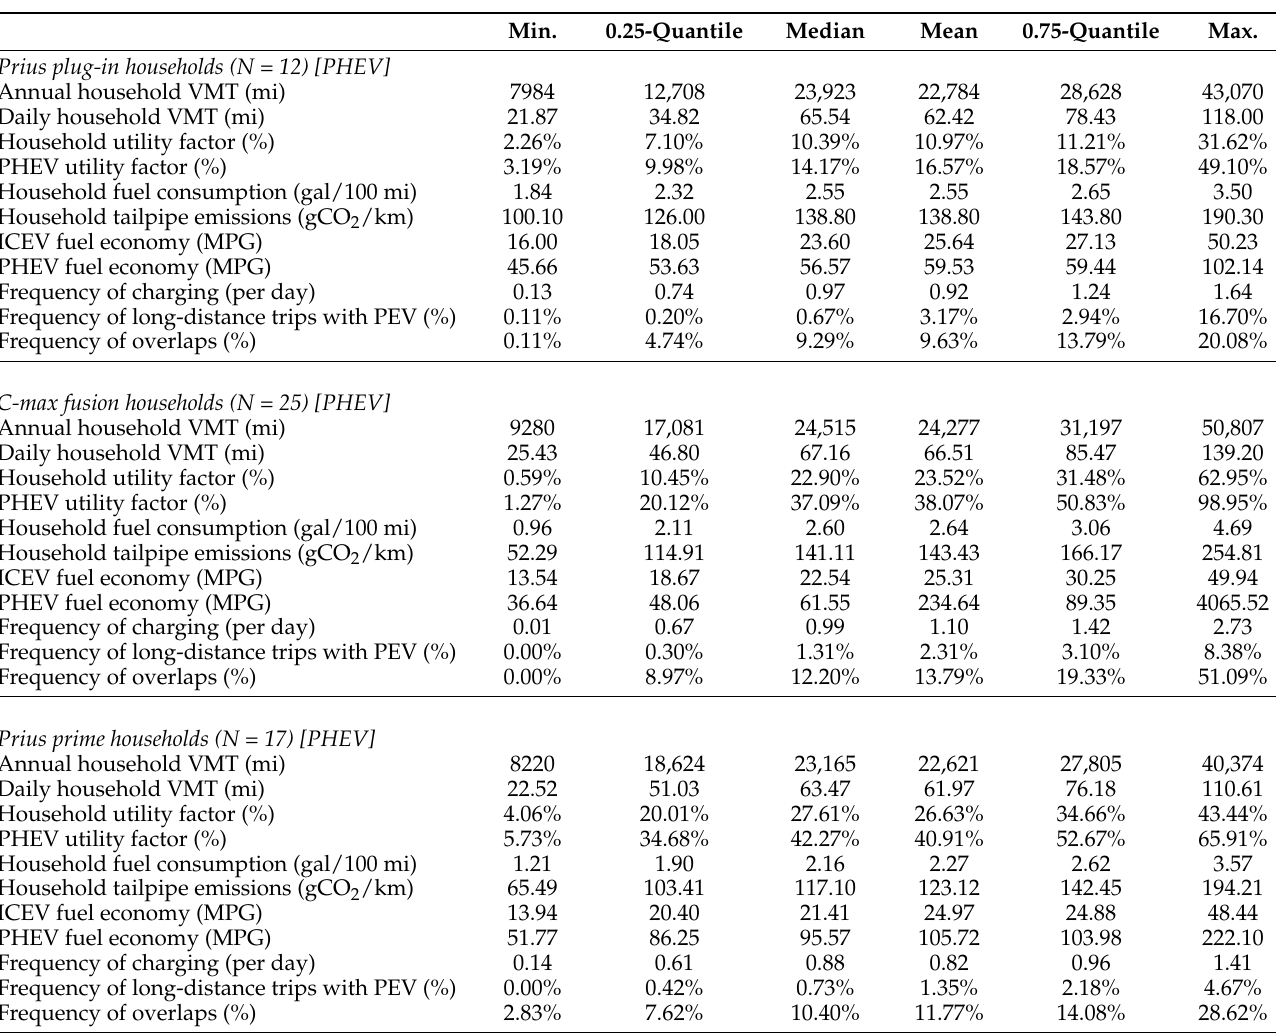
Table A1. Summary statistics of two-car households categorized by